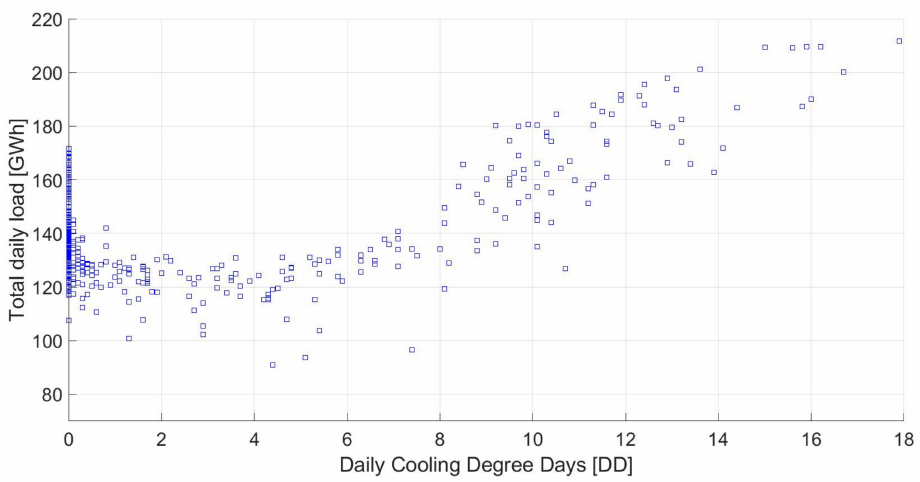
Figure 11. Correlation of the total daily electricity load in GWh with the daily cooling degree days (year